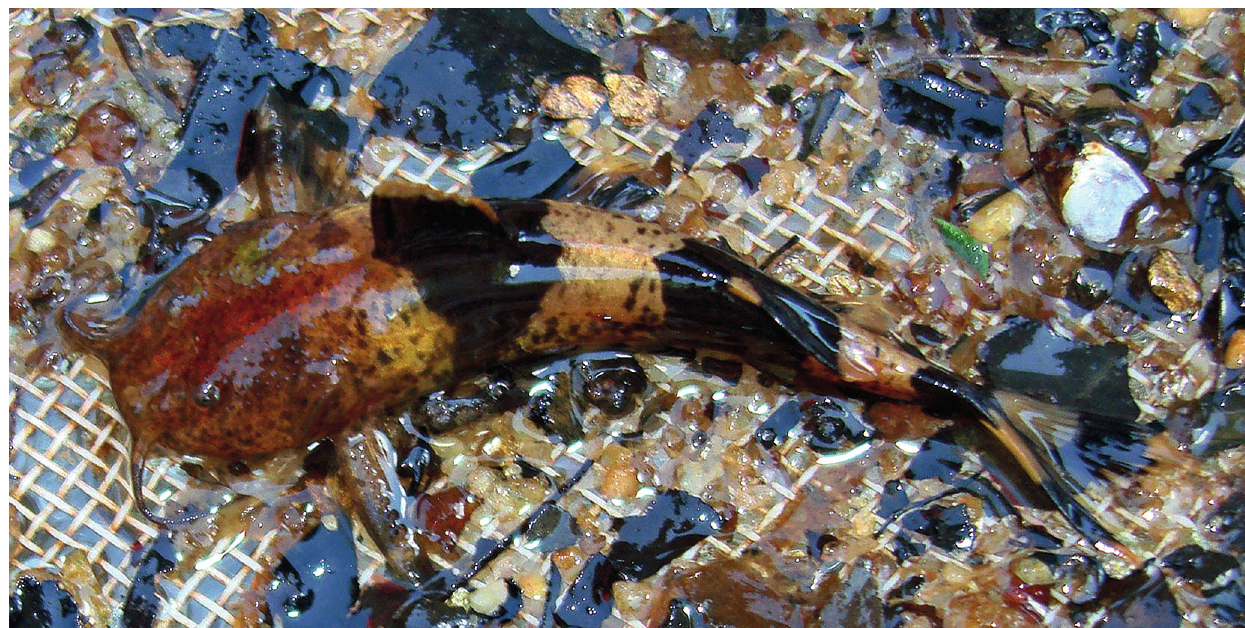
FIGURE 5 | Rhyacoglanis varii coloration in life, MZUEL 6039, paratype, 46.1 mm SL, rio do Peixe, upper rio Tocantins basin, Goianésia, state of Goiás,